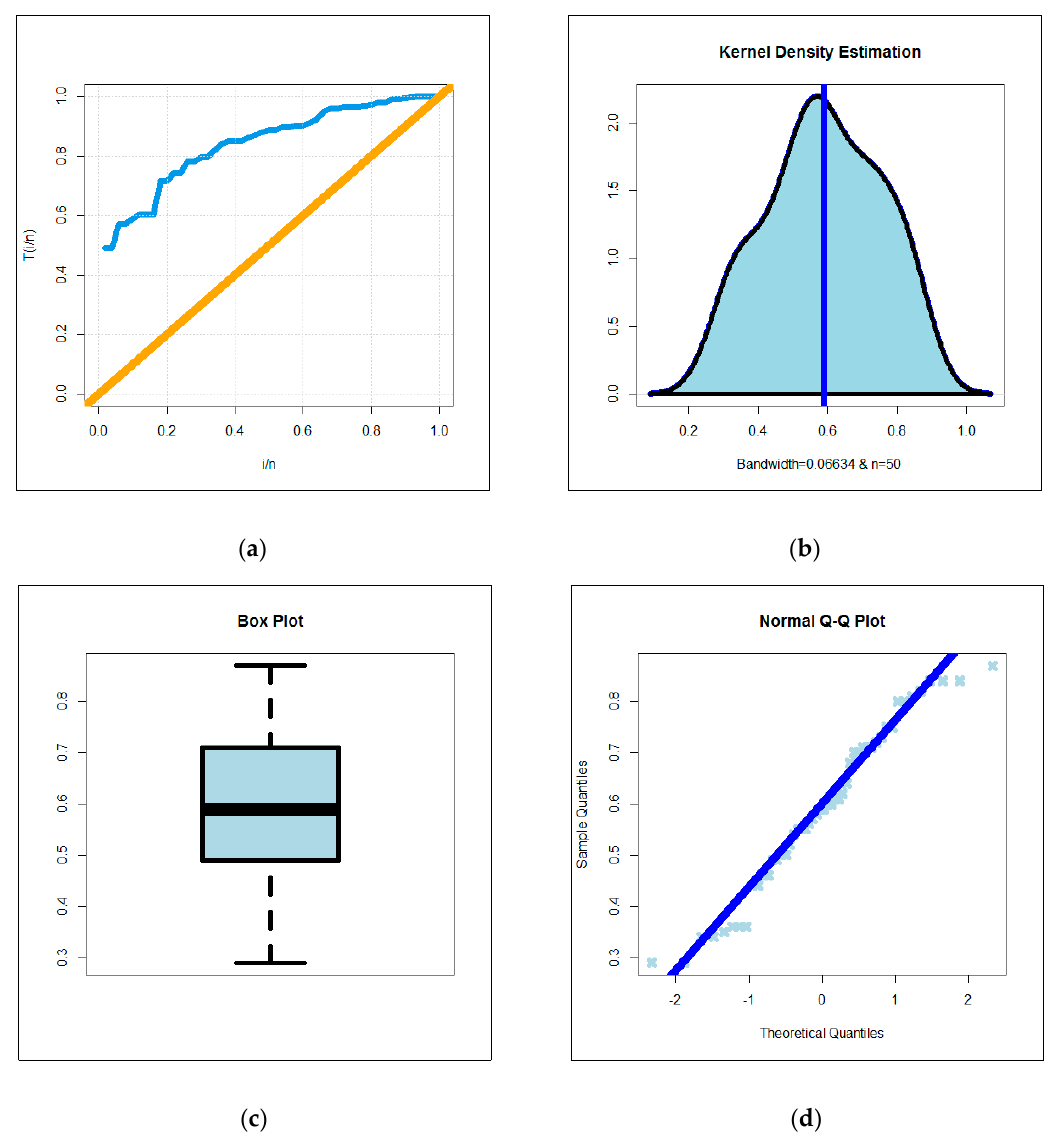
Figure 6. ( a ) TTT plot; ( b ) KDE plot; ( c ) box plot; ( d ) Q–Q plot for data set III . Table 11. C 1 , C 2 , K-S, and P-V for data set III .